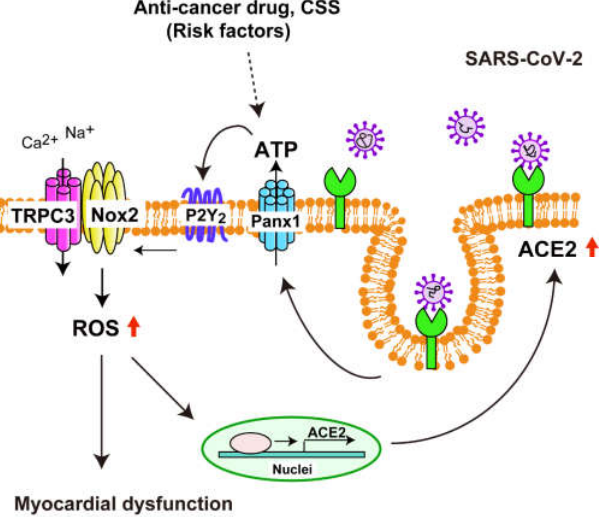
Figure 6. Hypothetical model of ACE2 upregulation in cardiomyocytes by the exposure to SARS-CoV-2 and cardiac risk factors in cardiomyocytes. Exposure to SARS-CoV-2, smoking, and anti-cancer drug treatment commonly upregulates ACE2 protein expression by ATP release through Panx1. The released ATP then induces TRPC3-Nox2 complex formation and promotes ROS production probably through P2Y 2 receptor stimulation [24]. The formation of TRPC3-Nox2 protein complex may lead to SARS-CoV-2-induced cardiac severity by amplifying ROS-dependent signaling in cardiomyocytes.